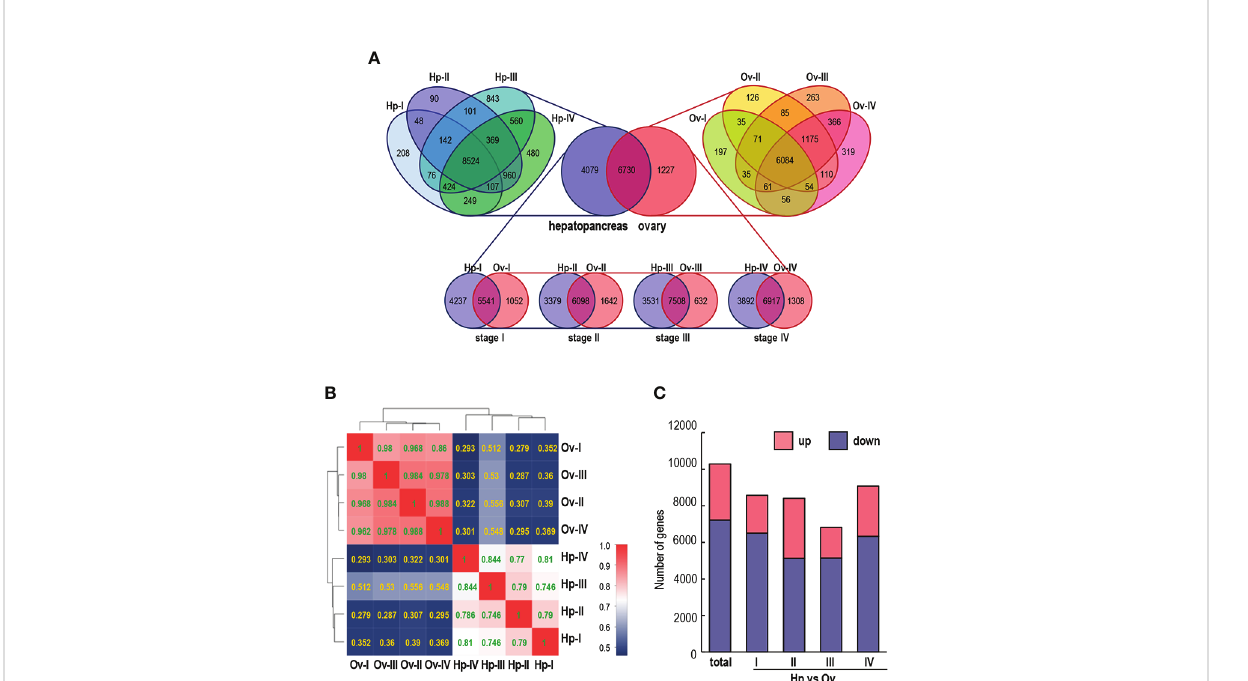
FIGURE 3 (A) Venn diagrams of unique and common genes in different stages of hepatopancreas and ovary development. (B) Correlation analysis of the four stages of ovary and hepatopancreas. The value is the correlation coef fi cient of the two samples; the larger the value is, the greater and more similar the correlation between the two samples. (C) Number of up- and down-regulated DEGs in each hepatopancreatic group compared to the ovarian group ( fi rst combinatorial bar) and pairwise comparison of four different staged hepatopancreatic and ovarian groups (last four combinatorial